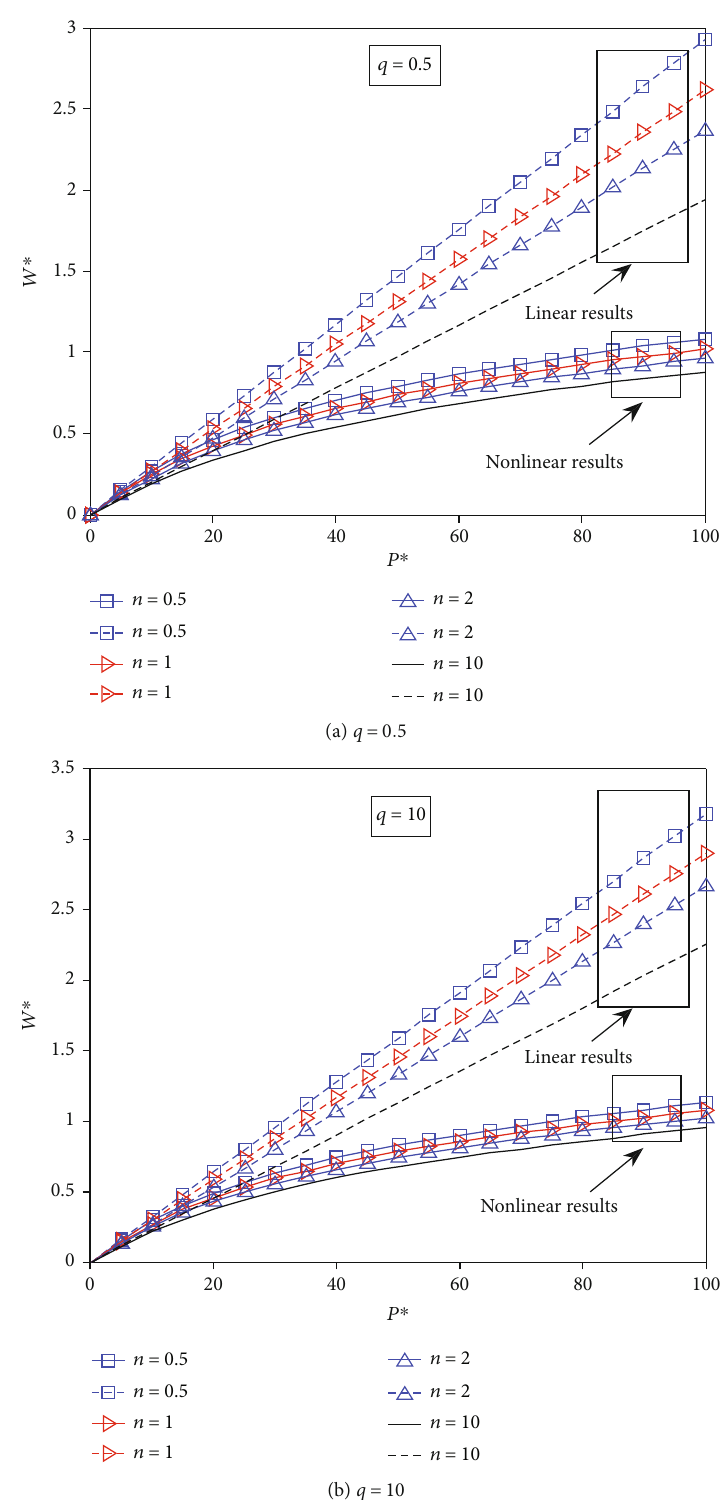
Figure 5: E ff ect of n on linear and nonlinear maximum de fl ection for two speci fi c values of q